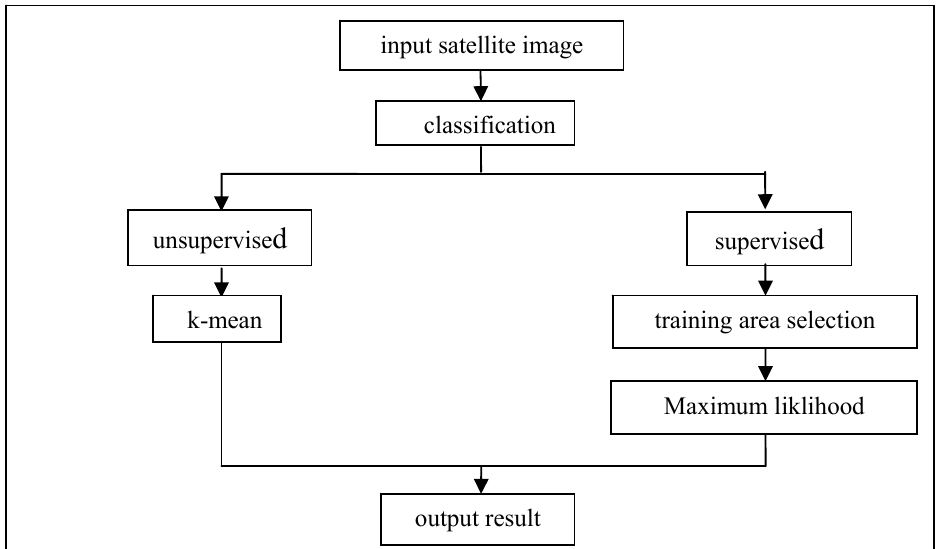
Fig.10: Block diagram of the classification methods using ERDAS